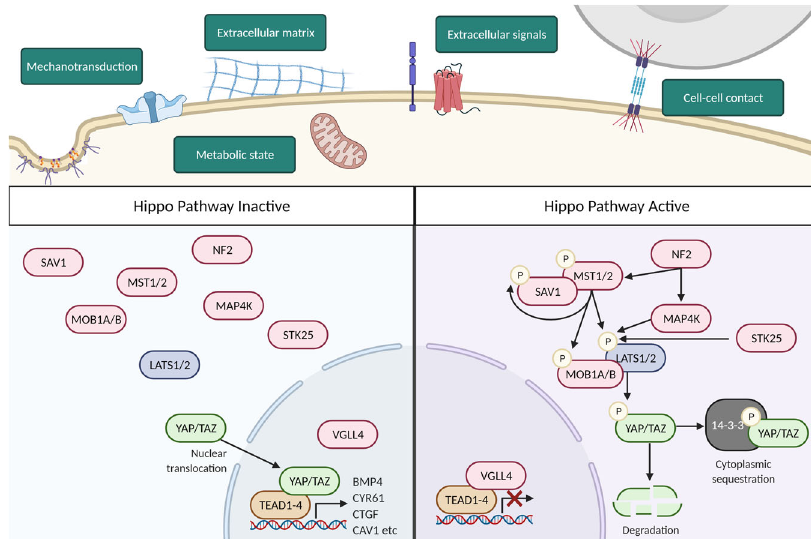
Fig. 1 Summary of the Hippo pathway signalling cascade and its stimuli. The Hippo pathway is regulated by the integration of a range of upstream stimuli. This includes mechanotransductive elements (such as caveolae and Piezo signalling), metabolism, extracellular matrix and integrin signalling, transduction of extracellular stimuli via mitogenic growth factor signalling and GPCRs, cell polarity and cell – cell contacts. Activation of the Hippo pathway triggers a phosphorylation cascade that leads to the phosphorylation of the Hippo pathway effectors YAP/ TAZ. Phosphorylation of YAP/TAZ redistributes YAP/TAZ to the cytoplasm, blocking TEAD-mediated gene expression. Hippo pathway inactivation prevents YAP/TAZ phosphorylation, allowing their nuclear translocation and hence TEAD-mediated gene expression. Note that MST1/2 (mammalian STE20-like kinase1/2) are encoded by STK4/3 , and TAZ by WWTR1 . Figure 1 is created in